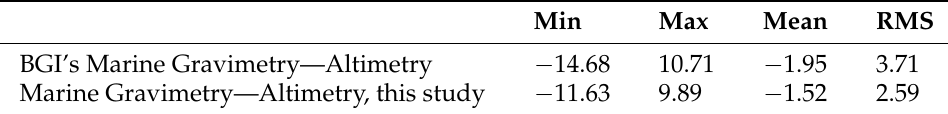
Figure 6. Data sets: ( a ) Gravity anomaly from satellite altimetry. The white points show the marine gravimetry measurement points from BGI while the black tracks show our marine gravimetry tracks. The red and orange solid lines show the location of two specific tracks used in Section 3.2.3; ( b ) gravity anomaly differences between satellite altimetry and marine gravimetry; ( c ) new combined gravity anomalies from satellite altimetry and marine gravimetry. ( d ) Digital elevation data from EMODnet model. Black tracks represent our ship-sounding measurements. Table 3. Gravity anomalies differences between altimetry and marine gravimetry (unit: